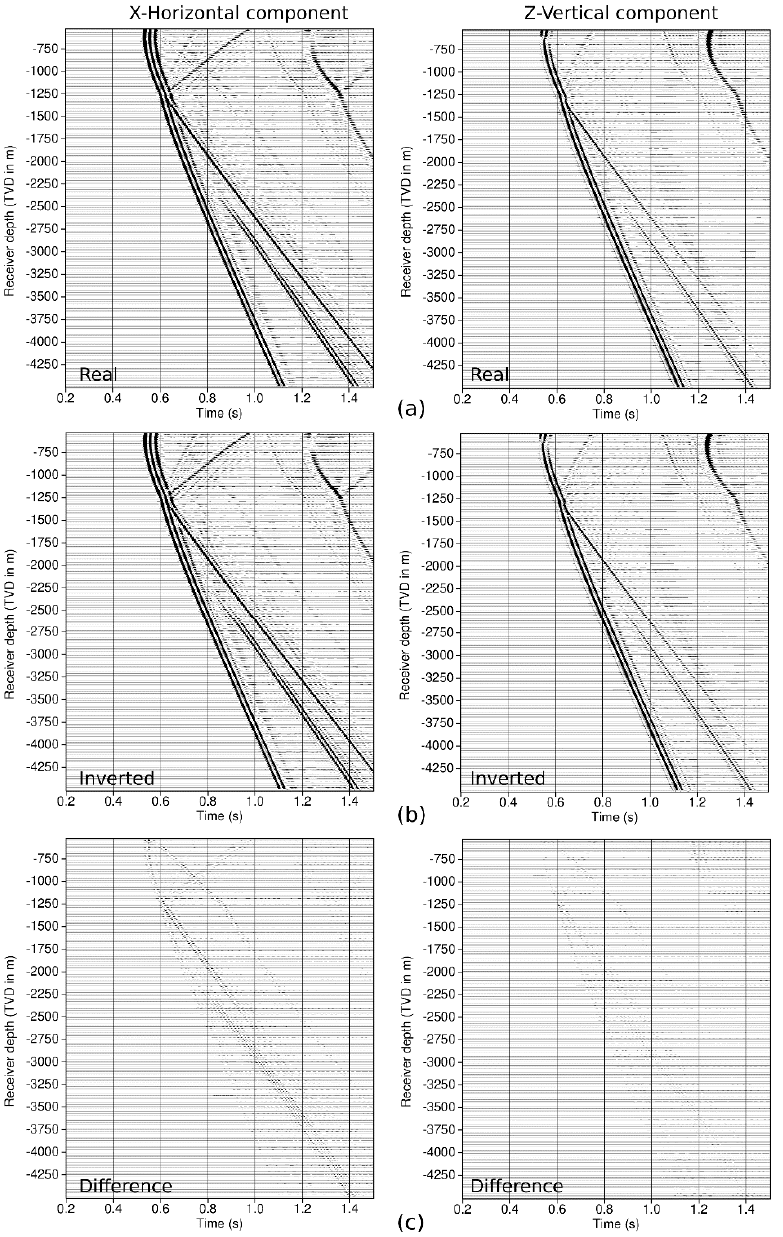
Figure 11. Seismograms recovered from the FWI of fault number 7 (for location, see Figure 7) for X (horizontal) component (left) and Z (vertical) component (right) obtained for zero offset source location. ( a ) observed X and Z components, ( b ) inverted X and Z components and ( c ) X and Z differences between ( a ) and ( b ).